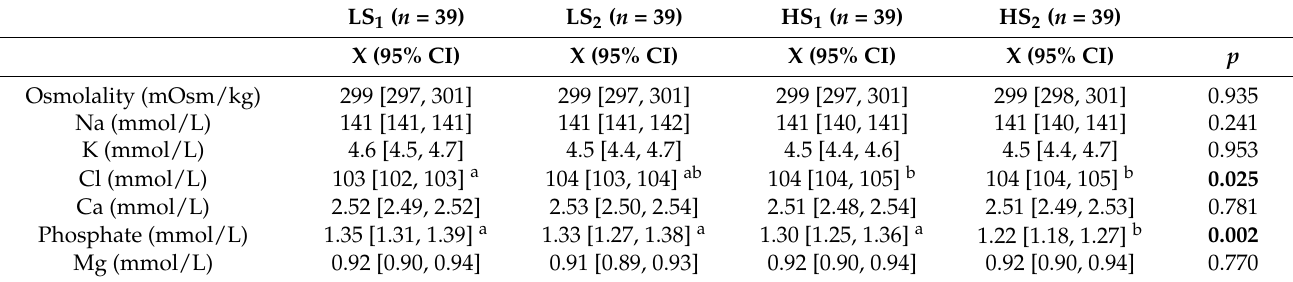
Table 4. The characteristics of plasma biomarkers among